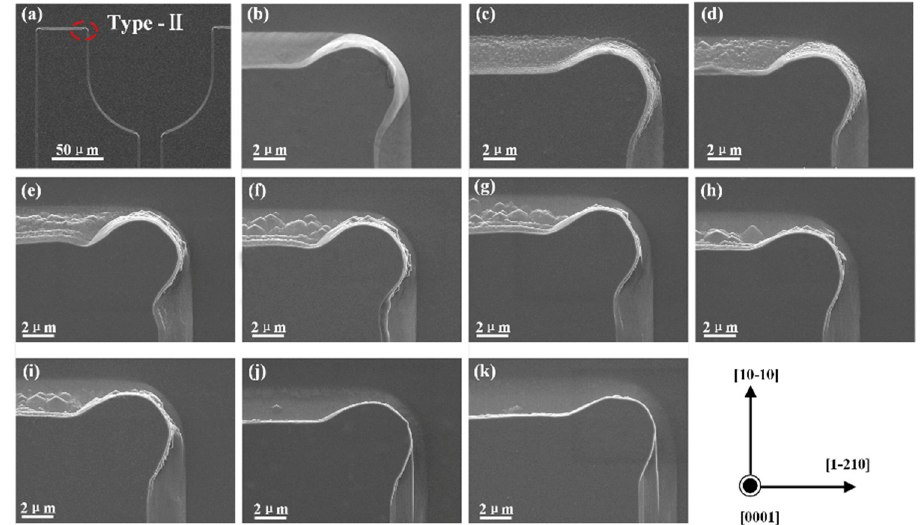
Figure 2. ( a ) SEM images of Type-II LED chips, the marked corner was chosen to show the morphology change after TMAH etching. ( b – k ) SEM images of the marked corner with different etching time: